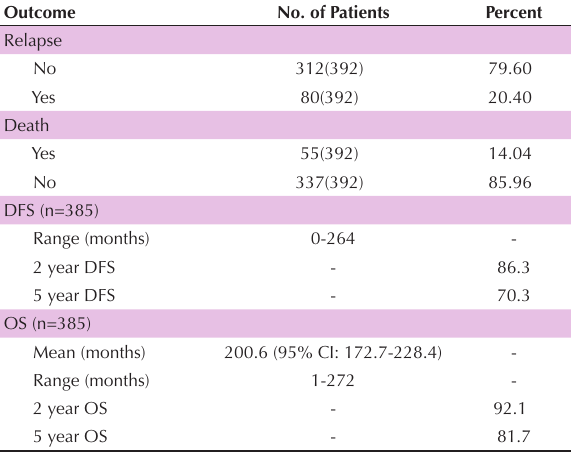
Figure 2 . The relationship between staging and overall survival in patients with breast